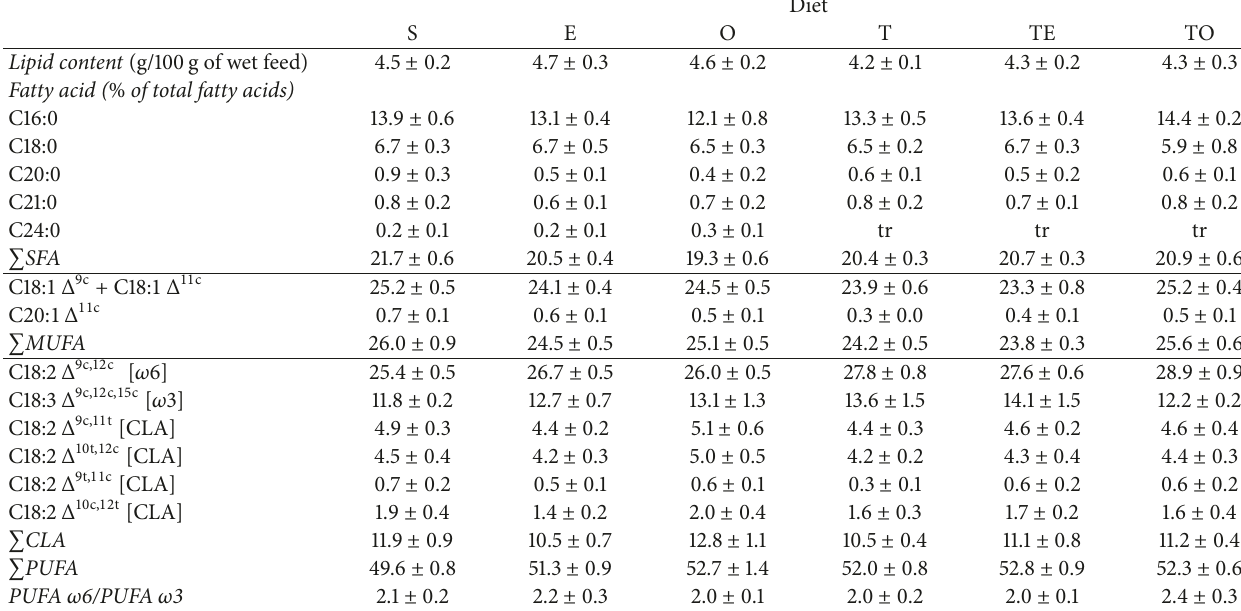
Table 2: Lipid content and fatty acid composition of pellet feeds belonging to different dietary groups. Diet S E O T TE TO Lipid content (g/100g of wet feed) 4.5 ±